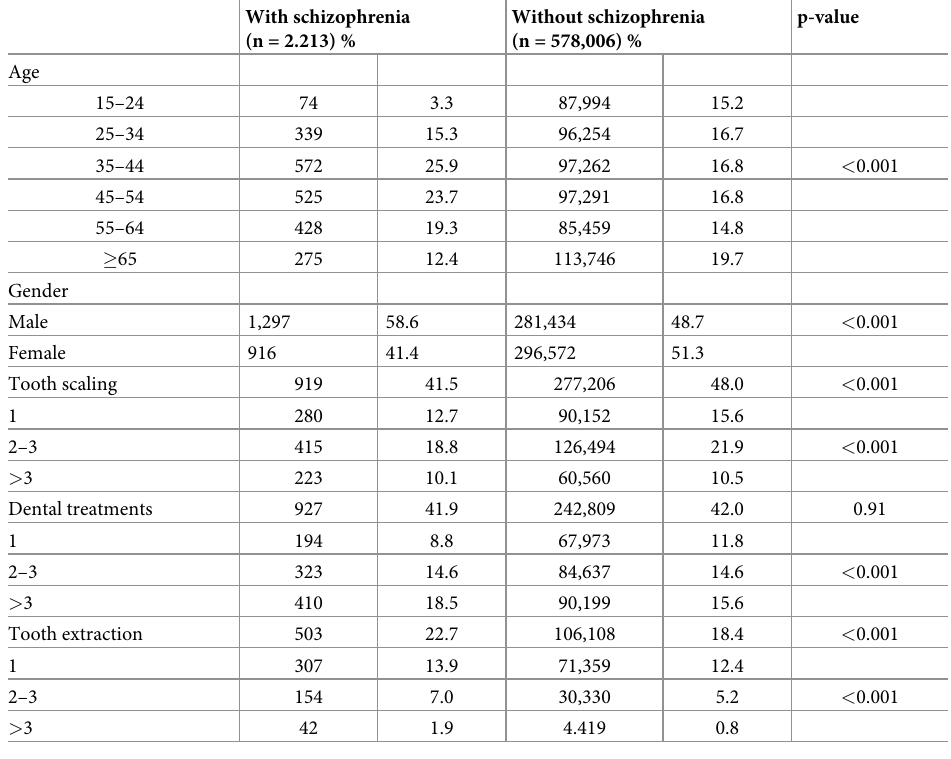
Table 1. Population and distribution of dental